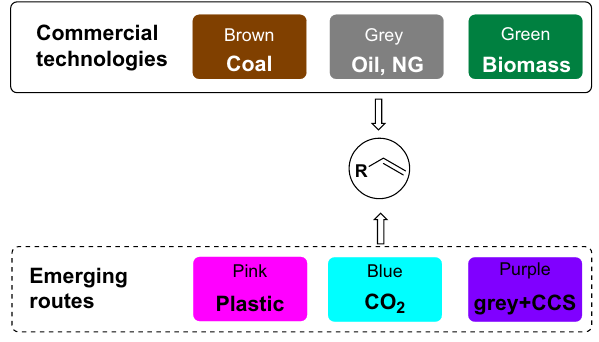
Fig. 1 Six feedstock types for olefin manufacture considered in this review. NG stands for natural gas, CCS for carbon capture and